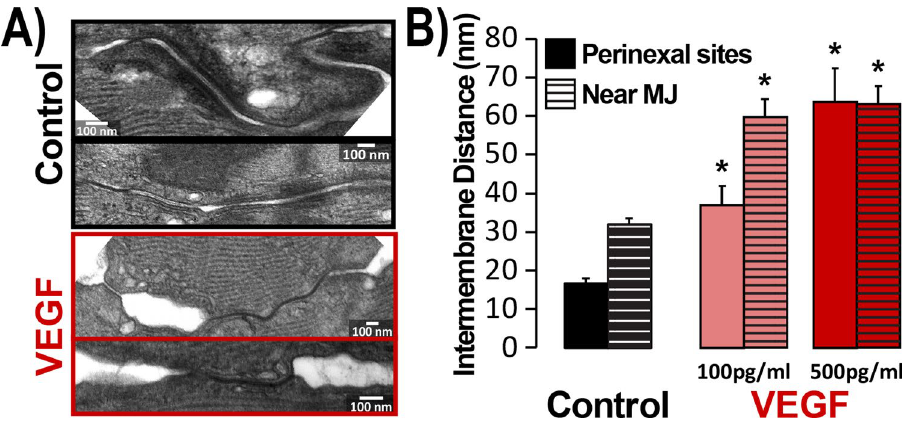
Figure 3. VEGF effects on ID ultrastructure. ( A ) Representative TEM images of IDs. ( B ) Summary plots of intermembrane distance at GJ-adjacent perinexal sites (solid bars) and MJ-adjacent (striped bars) ID sites (> 100 measurements/group/location from n = 3 hearts/group, * p < 0.05 vs.